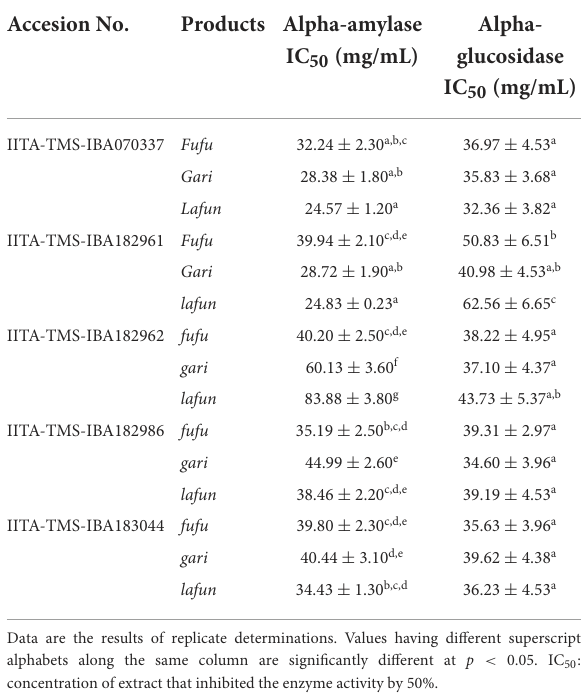
TABLE 3 Starch-digesting enzymes inhibitory activity of extracts of fufu, lafun and gari from five provitamin A biofortified yellow-fleshed cassava genotypes.